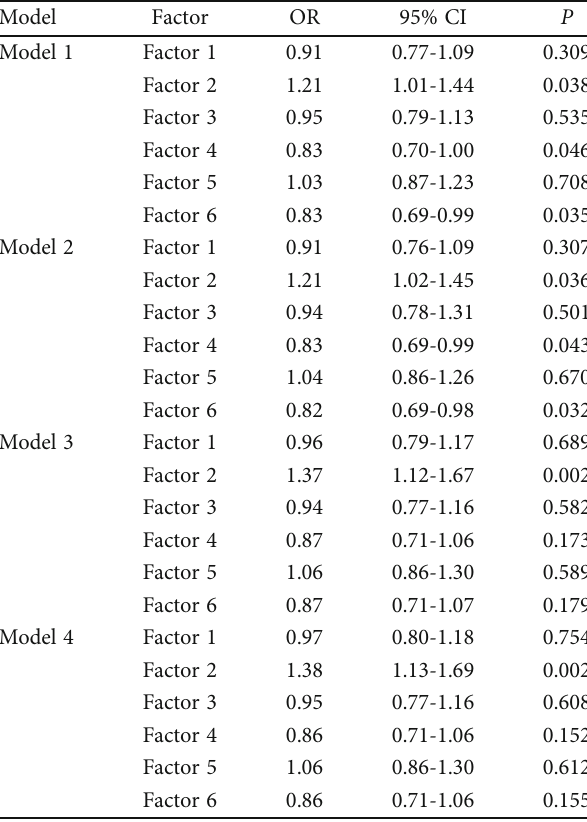
Table 4: Acylcarnitines are associated with DPN in univariate and multivariate